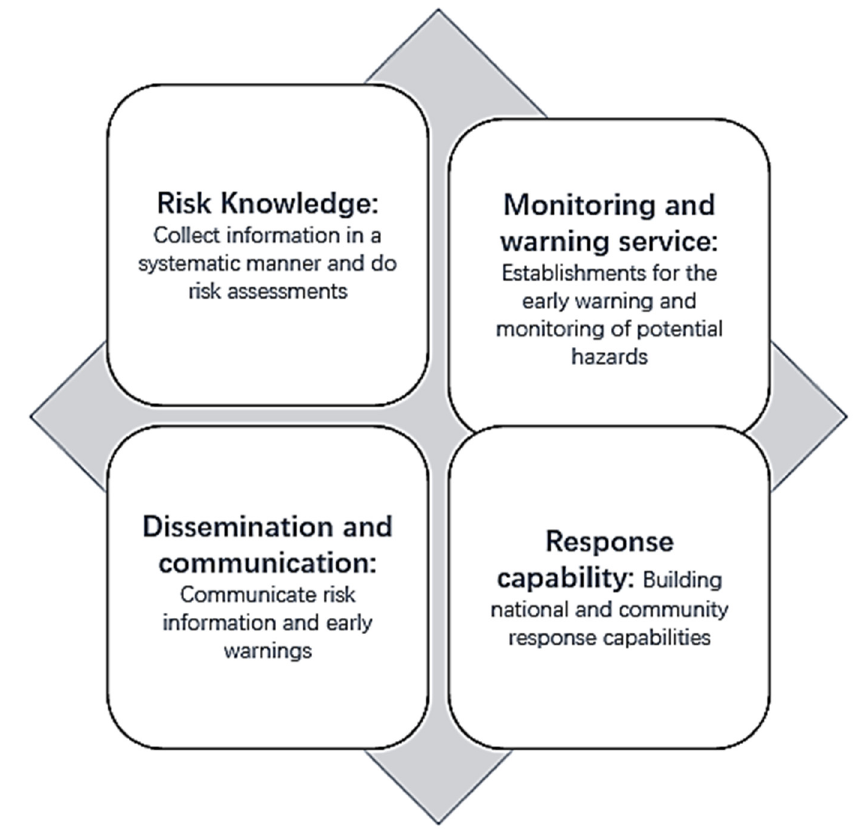
Figure 2. People-centered flood early warning system.